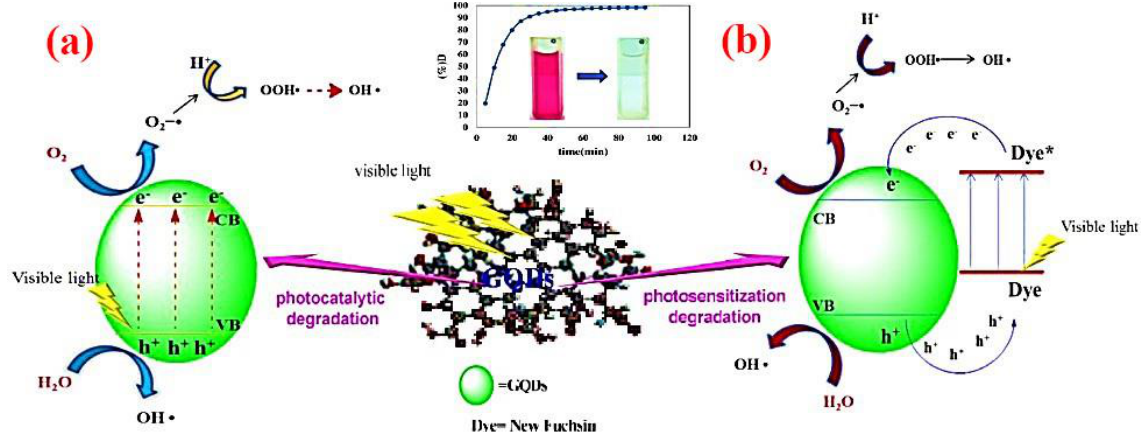
Figure 10. Degradation mechanism of new fuchsin via ( a ) photocatalytic and ( b ) photosensitization pathways using GQDs under visible light irradiation. Reproduced form [192].